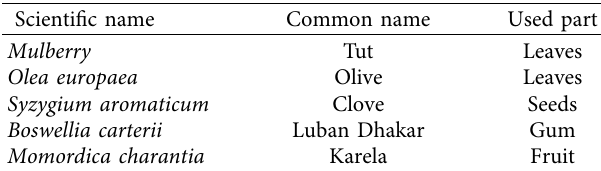
Table 1: The studied plant species and the parts used for both diabetes treatment and